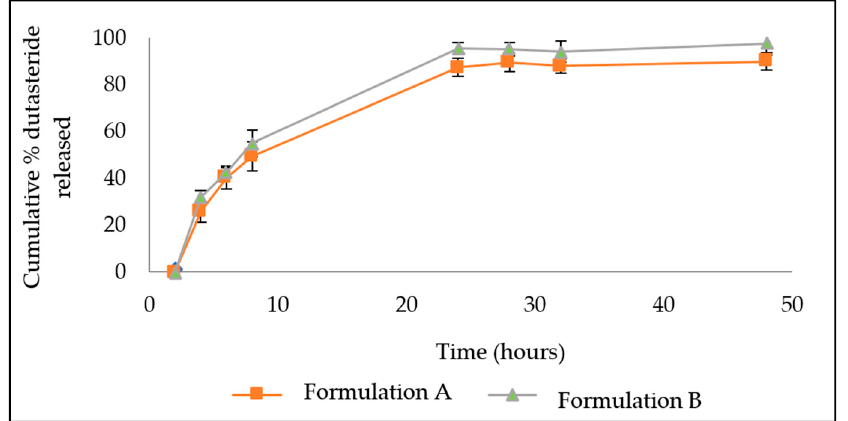
Figure 6. Dutasteride release from DST-LNP for Formulation A and B over 48 h.